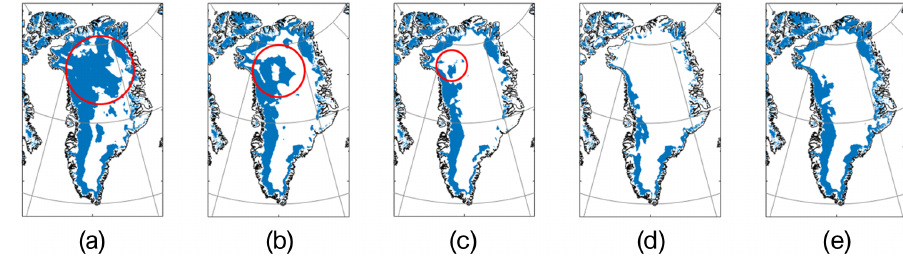
Figure 6. Melting maps obtained using the (a) M + 30, (b) M + 35, (c) M + 40, (d) 245K and (e) MEMLS algorithms over the Greenland ice sheet on 13 July 2008. An example of an area presenting the false detection problem is shown in the red